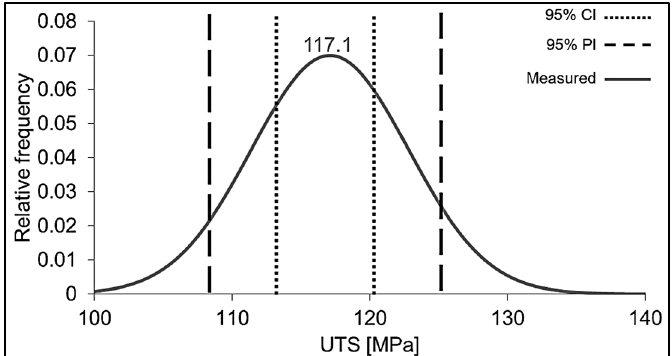
Figure 8. Distribution of UTS values for specimens 3D-printed with the optimal parameter combi- nation, according to the DoE prediction model. Confidence and prediction intervals are delimited according to Table 5.